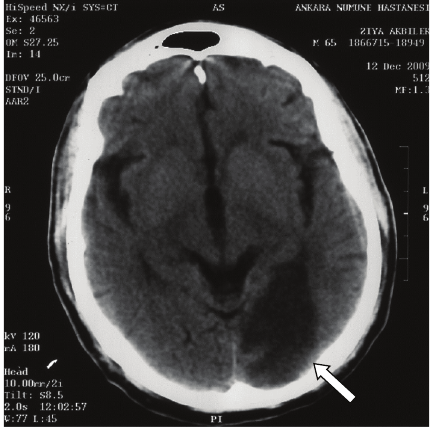
F 2: Le occipital infarct area in the CT scan (white